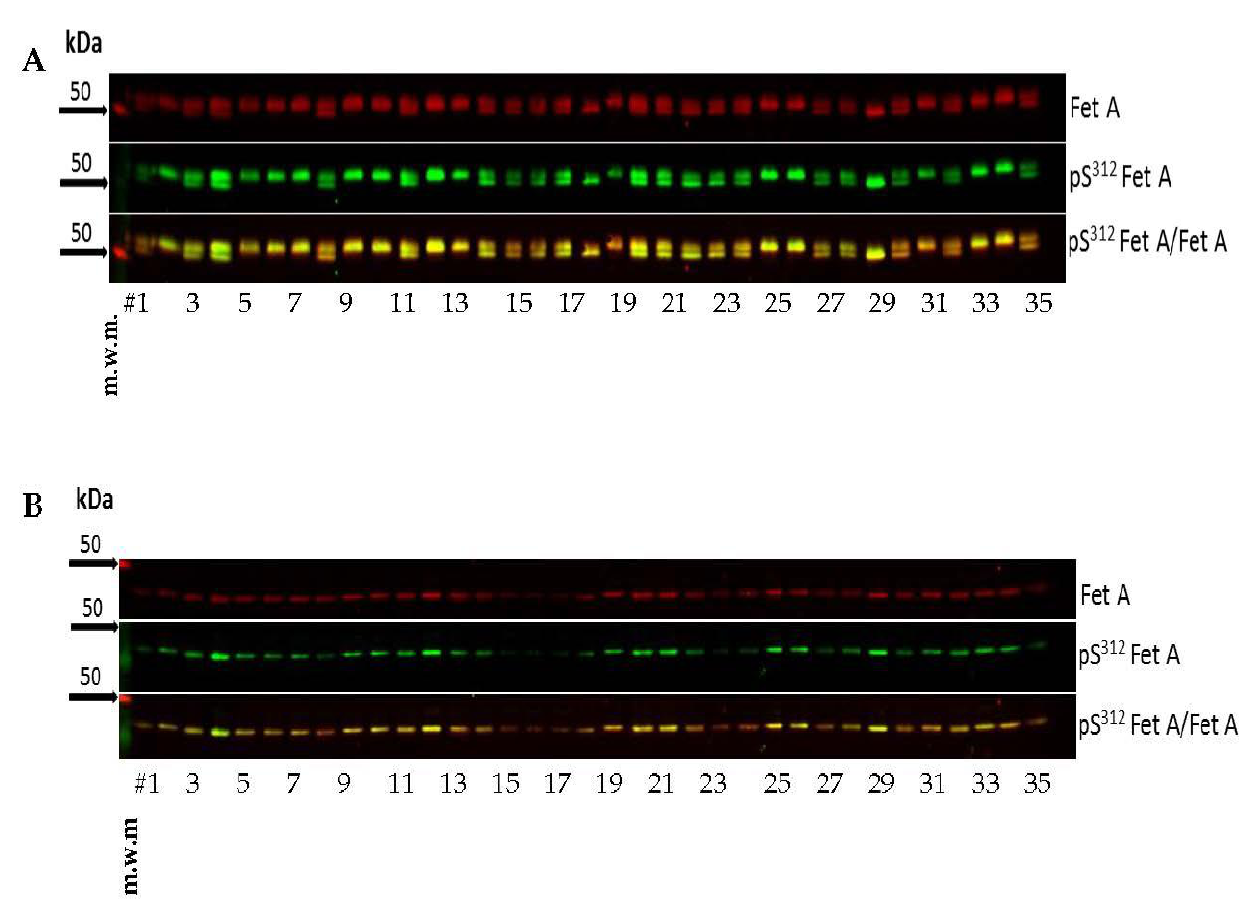
Figure 5. Analysis of plasma pSer 312 pFet A and Fet A samples obtained from non-diabetic individuals (#1–35) Untreated ( A ) and completely deglycosylated ( B ) samples obtained from non-diabetic individuals ( n = 35) were analyzed by Western blotting as described in the Method section; m.w.m = molecular weight marker. Table 3. Univariate associations of densitometric results obtained from Western blots of 35 individuals (Figure 5) for pFet A, band (1) and band (2), and deglycosylated Fet A. pFet A (1) pFet A (2) pFet A Sum pFet A